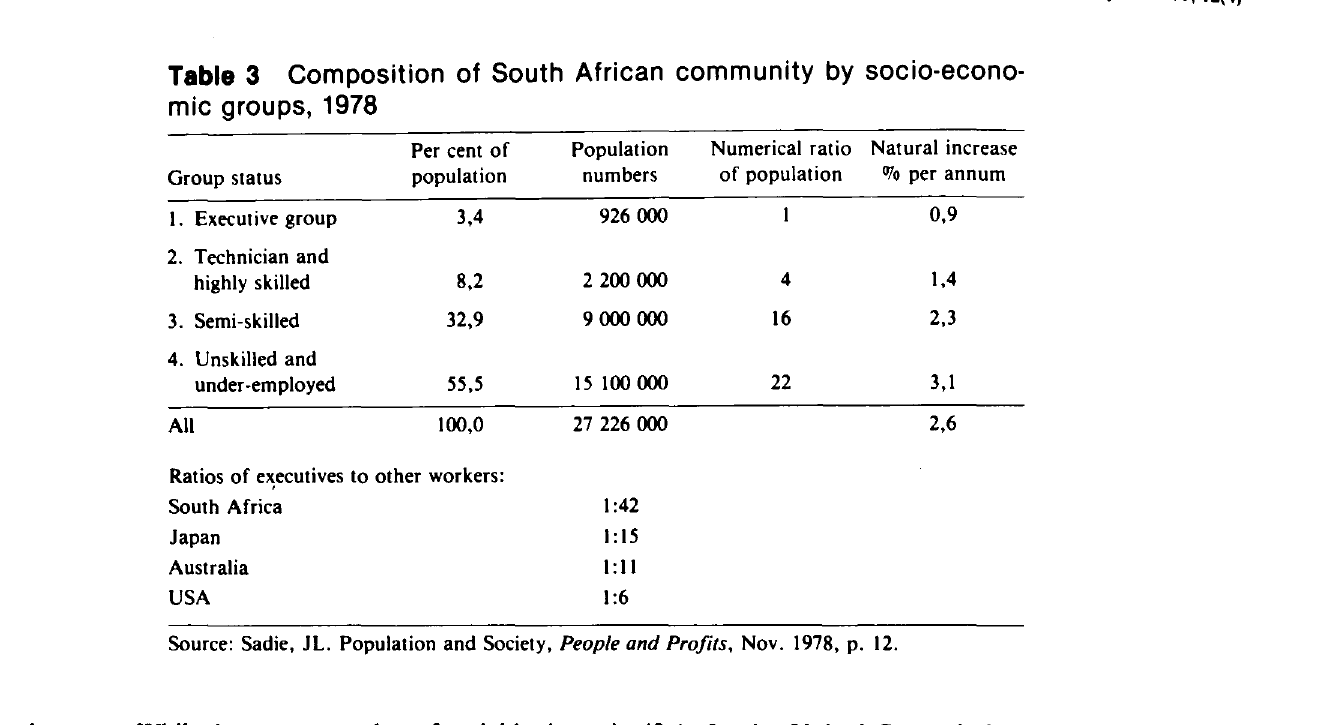
countries are somewhere between 10 - 15: I. I do not know what ratio is ideal for South Africa. I do know it is advancing workers through the various levels. The ratio will not be improved by desegregation, recognizing a black union or the like, and if we do not get the ratio right and fairly quickly, codes of practice and monitoring them will be the least of our